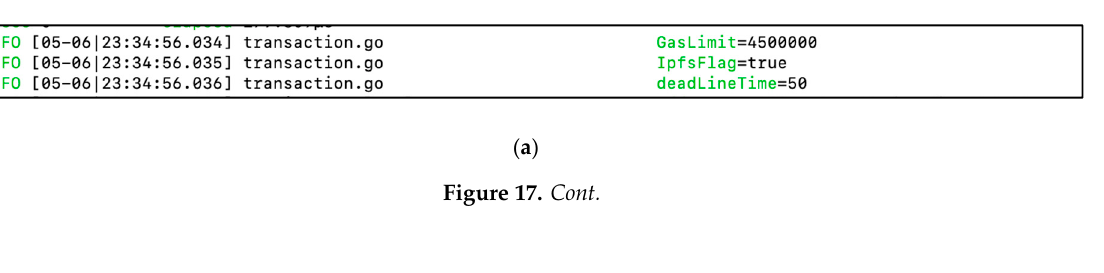
Figure 16. ( a ) Transaction with deadline time of 36, ( b ) full hash of the transaction, ( c ) gas limit 2,000,000 of the same hash.